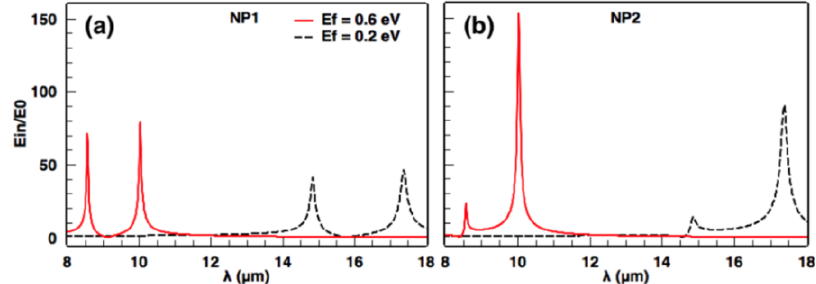
Figure 9. Internal field enhancement spectra with di ff erent Fermi energy levels in ( a ) NP1 and ( b ) NP2, respectively. Other geometric parameters are the same as in Figure